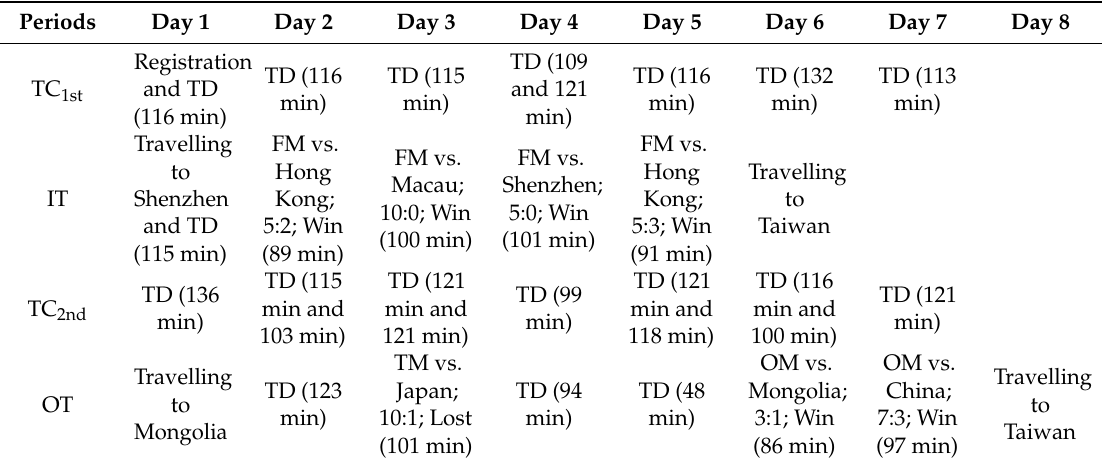
Table 1. The schedule of domestic training camps, invitation tournament, and o ffi cial